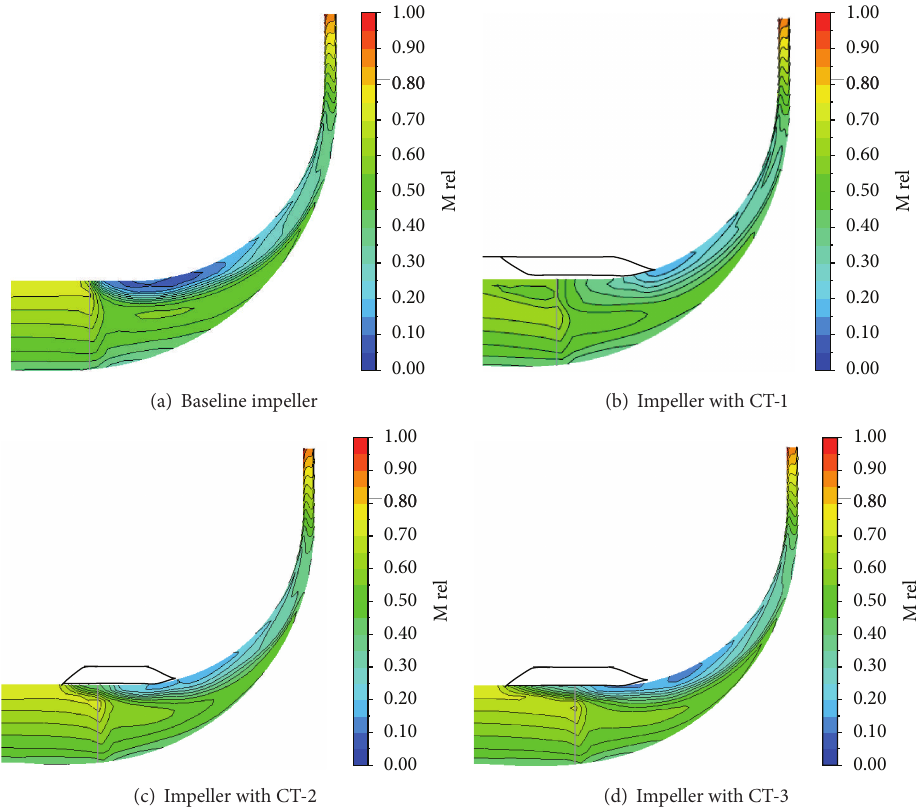
Figure 17: Circumferentially mass averaged relative Mach number distribution in the meridional plane for impellers without and with three casing treatment geometries at stall mass flow rate of baseline